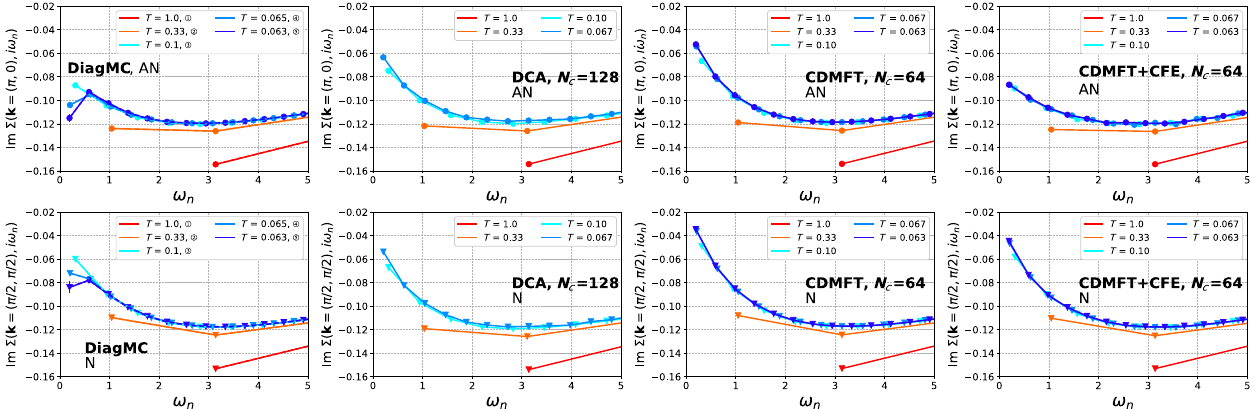
FIG. 9. Imaginary part of the self-energy for the antinode (upper row) and node (lower row) as a function of Matsubara frequencies for DiagMC (first panel on the left-hand side), DCA ( N extrapolated CDMFT (CDMFT þ CFE, N